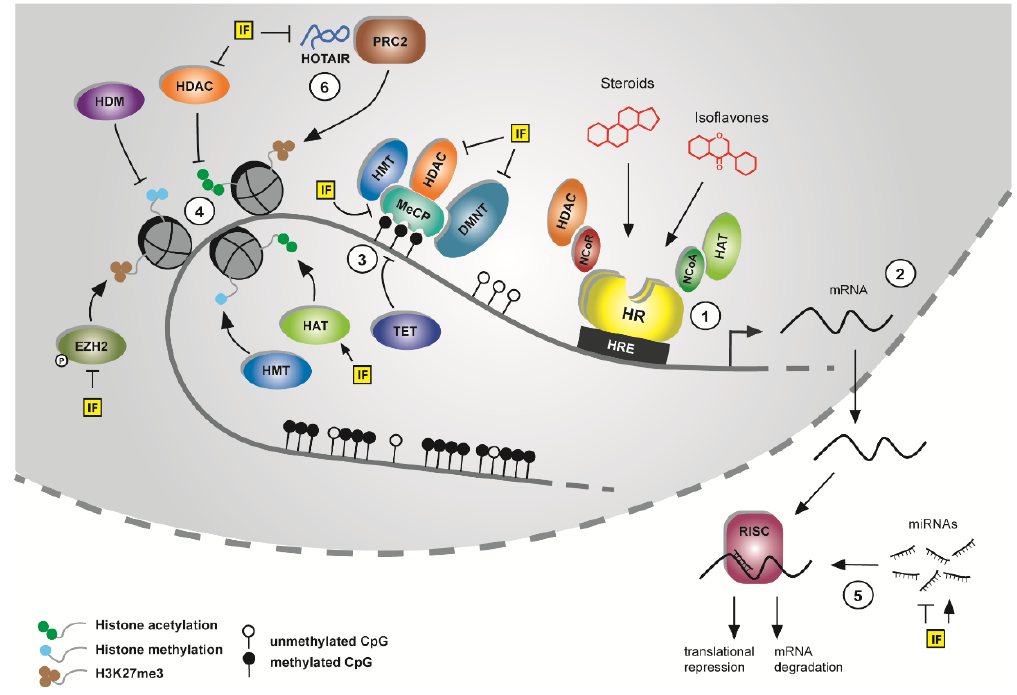
Figure 2. Overview of the impact of soy IF on the